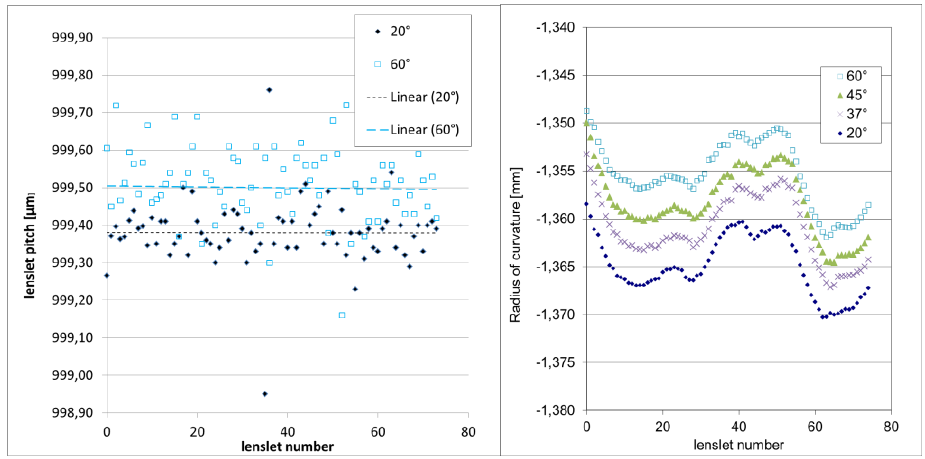
Figure 2. Temperature dependent pitch ( left hand side) and radius ( Right hand side) changes of an ORMOCOMP ® on B33 glass lens array measured using a mechanical profiler (FormTalysurf PGI/ Taylor